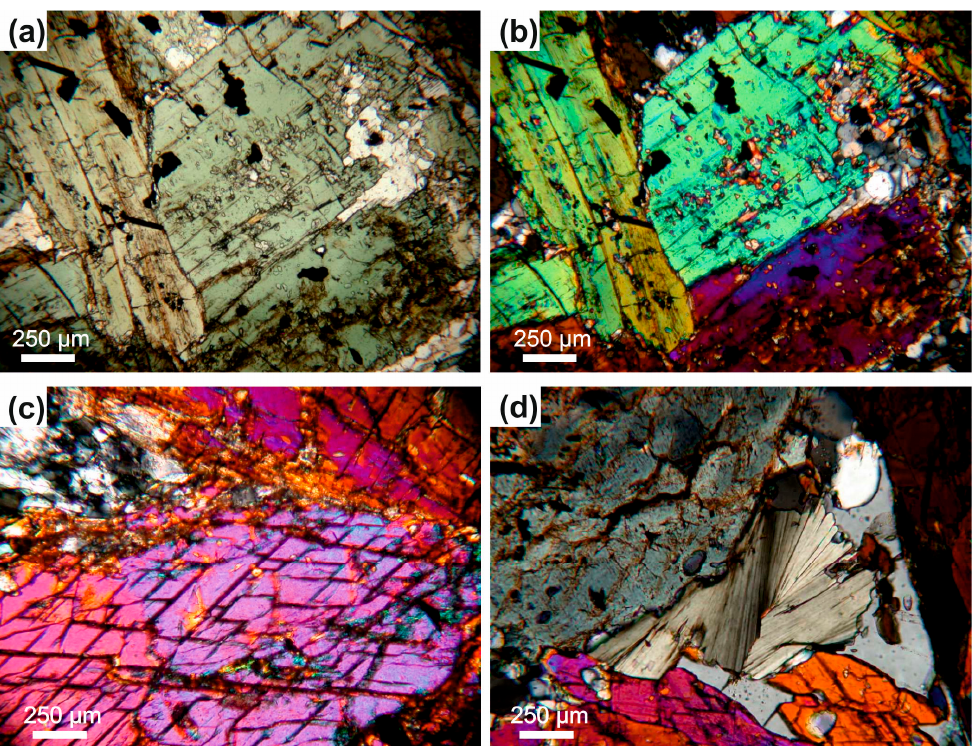
Figure 3. Photomicrographs of the studied samples from the Aravalli area. ( a – c ) pseudomorphic large Ca-amphibole grains making spinifex-like texture in Aravalli pillow lava, ( d ) retrogressive Mg chlorite after amphibole.